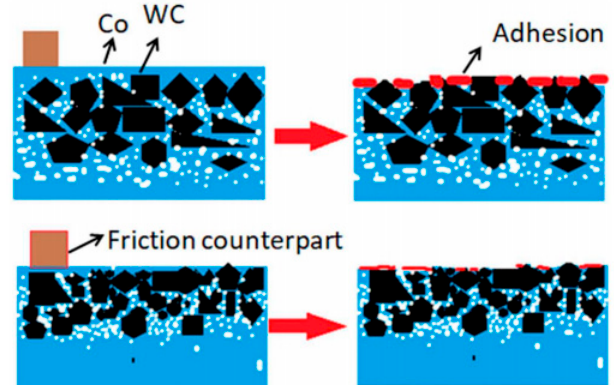
Figure 7. Schematic of wear mechanism of WC–(nano WC–Co) [55]. Reprinted with permission from [55]; 2019 Elsevier.